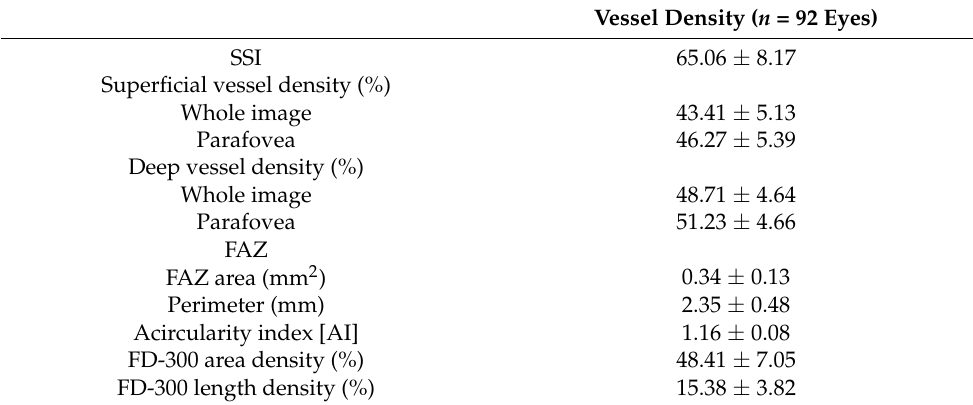
Table 2. Vessel Density in Superficial and Deep Vascular Capillary Plexus and FAZ